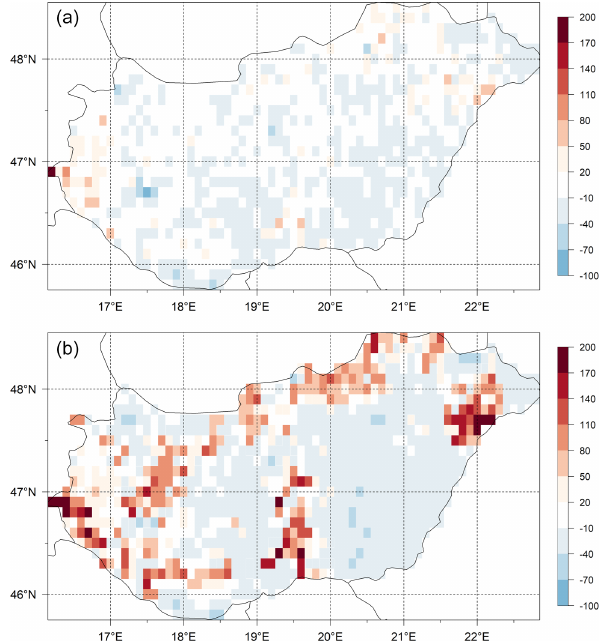
Figure 15. Differences (expressed as signed relative error, %) be- tween the simulated and observed SOC data for the 0–30 layer (SOC0-30) using the initial (a) and optimized (b) soil parameters. Visual comparison of the maps reveals the success of the optimiza- tion in terms of capturing the overall SOC for the whole country